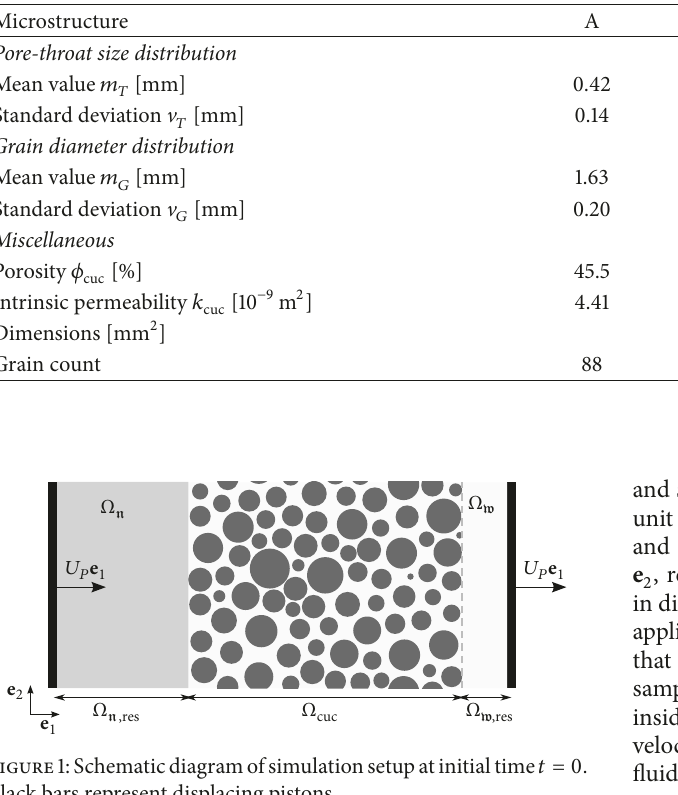
Table 1: Overview of microstructure parameters. Intrinsic permeabilities 𝑘 were calculated using single-phase flow simulations.